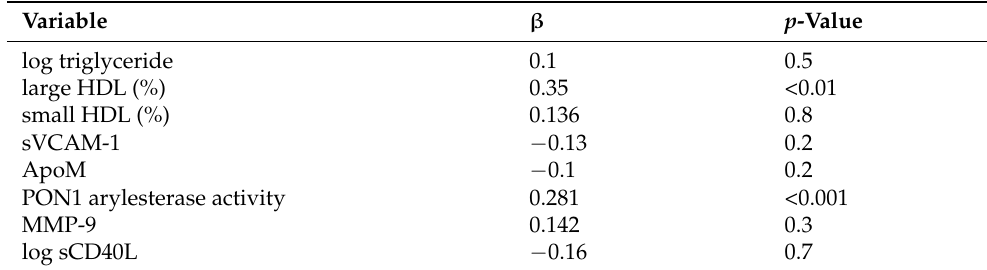
Table 3. Backward stepwise multiple regression analysis to determine significant predictor(s) of sphingosine 1-phosphate (S1P).